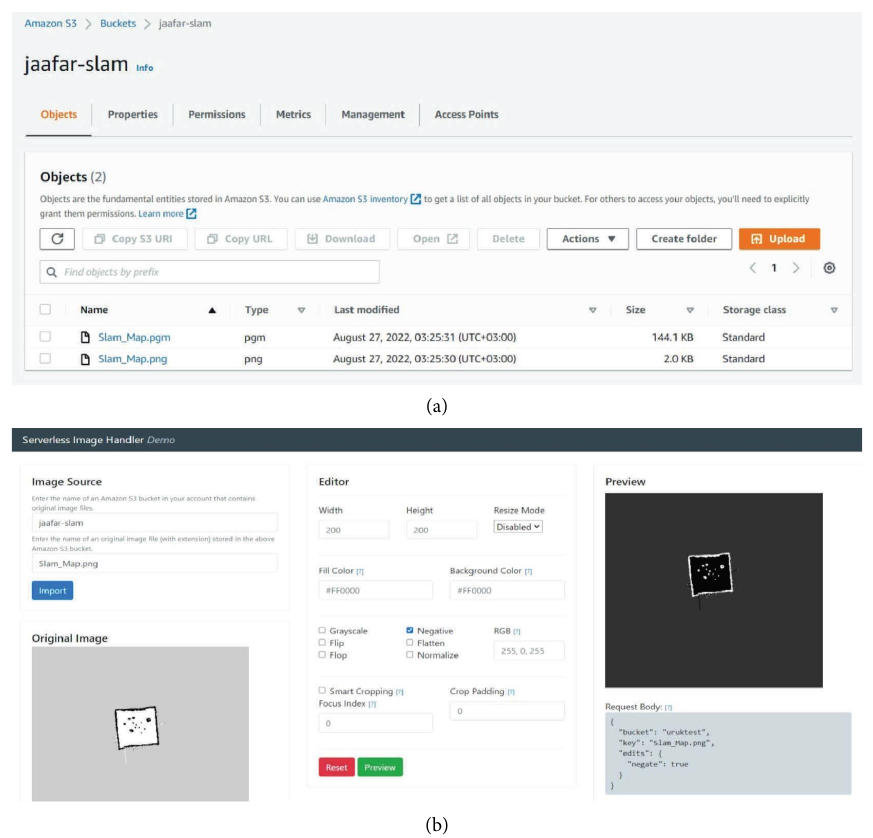
Figure 13: (a) Upload of the environment to AWS S3; (b) the SIH